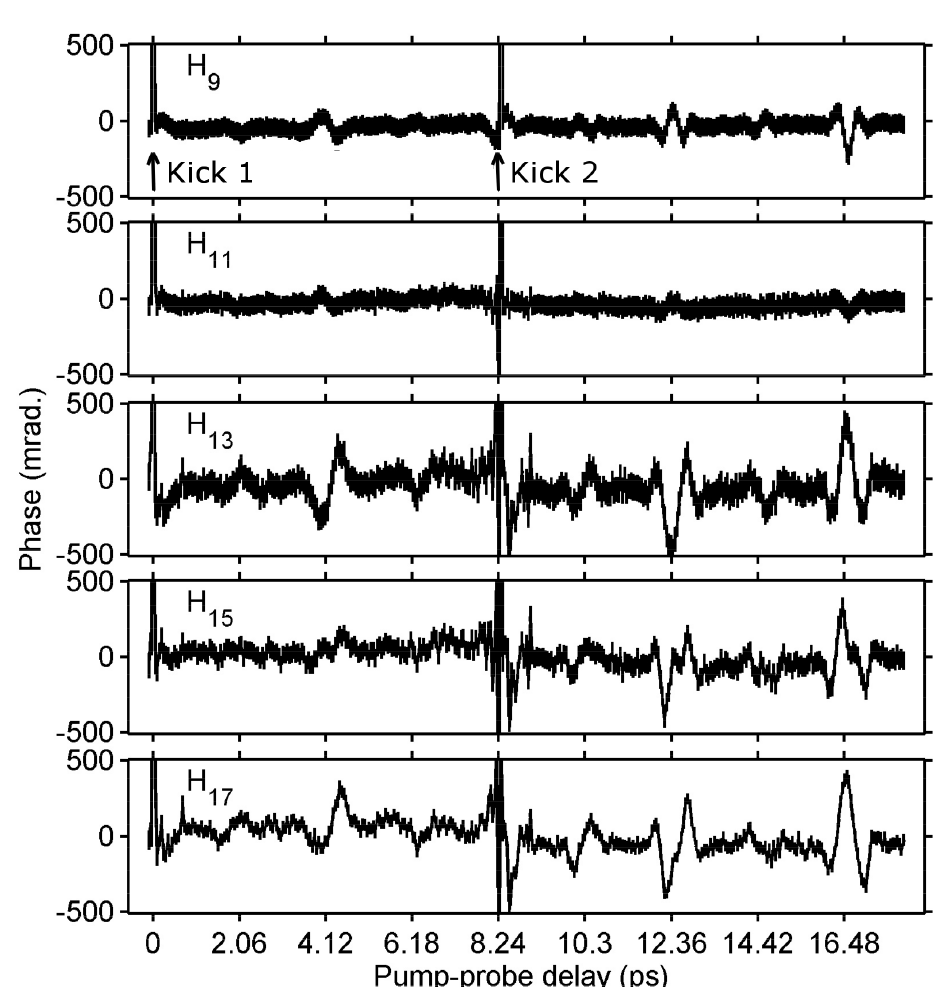
Figure 7. The phase of H to H generated in nitrogen as a function of the alignment 9 17 pump-HHG probe delay. Two kickers (indicated with arrows on the first row) separated by one full rotational period (8.24 ps) are used to increase the degree of molecular